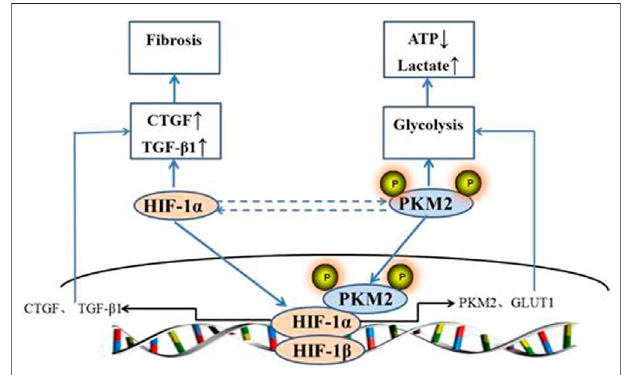
FIGURE 8 | Schematic diagram of metabolic reprogramming of hypertensive kidney injury promoted by HIF-1 α /PKM2 positive